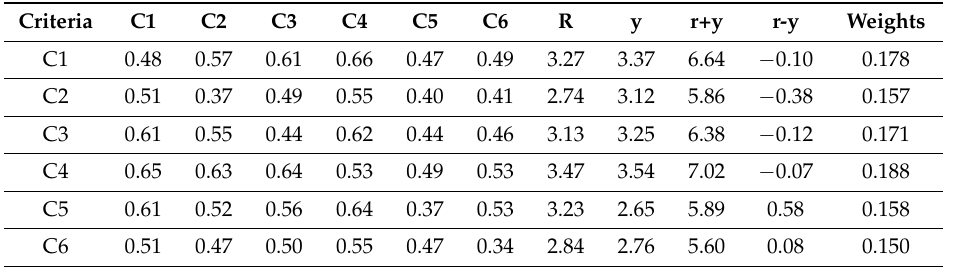
Table 9. Defuzzified values of matrix and weights of criteria.